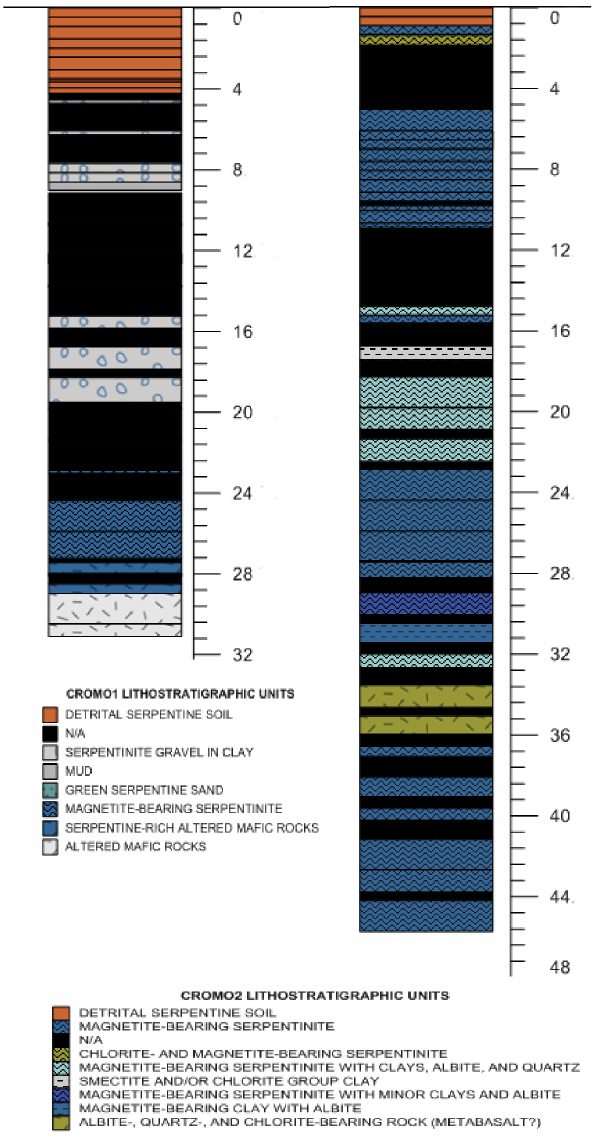
Figure 2. Lithostratigraphic summaries of CROMO1 and CROMO2. Left: CROMO1, the Core Shed area well, was drilled at 38 ◦ 51.711 0 N, 122 ◦ 24.856 0 W, and is in a grassy flat with low shrubs and a few introduced trees. Reddish altered peridotite blocks are upslope of the site, with green-blue scrapes showing fresher serpentinite where soil cover has eroded. A few meters of soil was underlain by bedrock. B.O.H. was at a depth of 45m. Post- drilling measurement of pH in the uncased borehole gave a pH of 11.4. Right: CROMO2, the Quarry Valley well, was drilled at 38 ◦ 51.724 0 N, 122 ◦ 25.827 0 W, and is characterized by serpentine meadows, steep slopes with altered peridotite outcrops. A few me- ters of soil graded into less altered material and finally bedrock. Bottom of hole (B.O.H.) was at a depth of 31m. Post-drilling mea- surement of pH in the uncased borehole gave a pH of